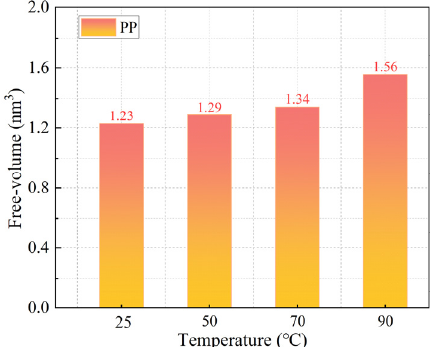
Figure 11. Molecular model. ( a ) molecular chain structure of PP; ( b ) the free volume of PP.